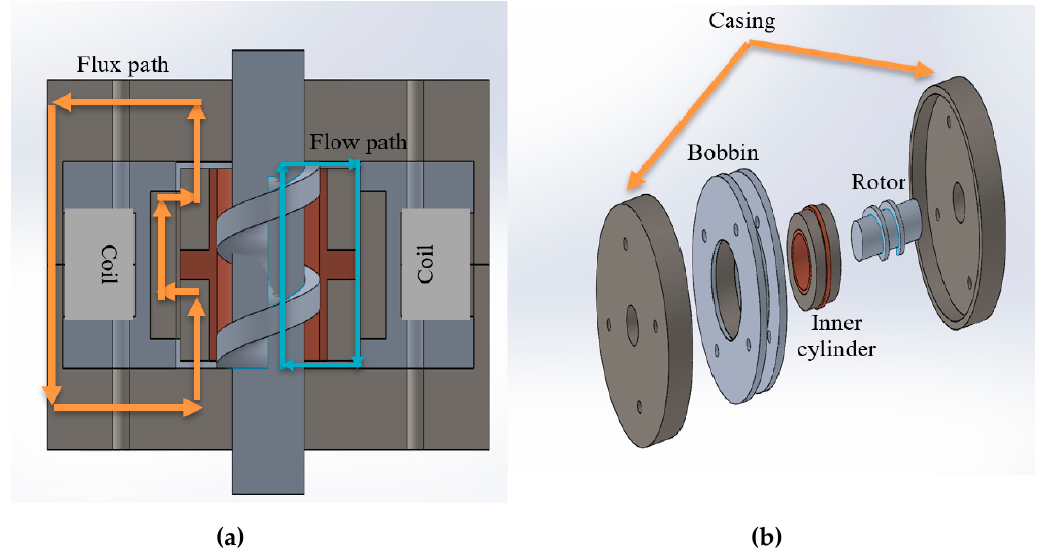
Figure 1. Illustration of the proposed rotary magneto-rheological (MR) damper. ( a ) Cross-section view; ( b ) exploded view.